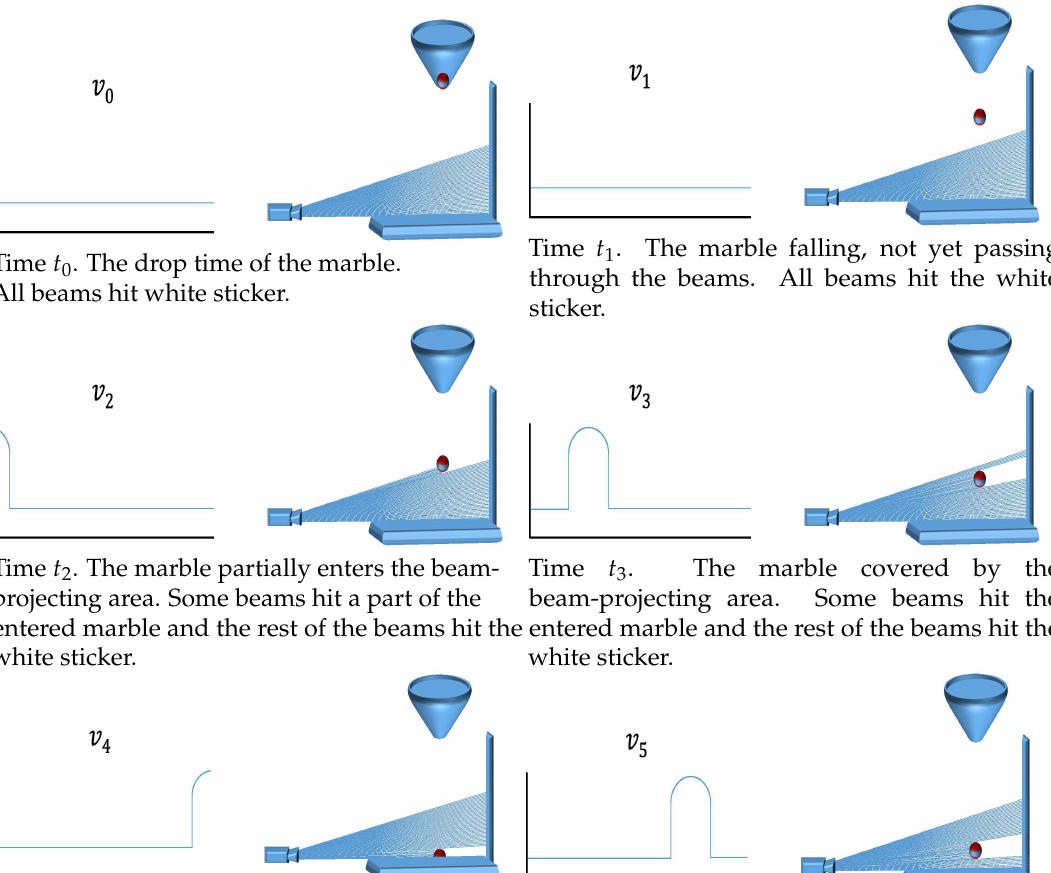
Time t 5 . The marble oscillates on the board upwards. Figure 10. Cont